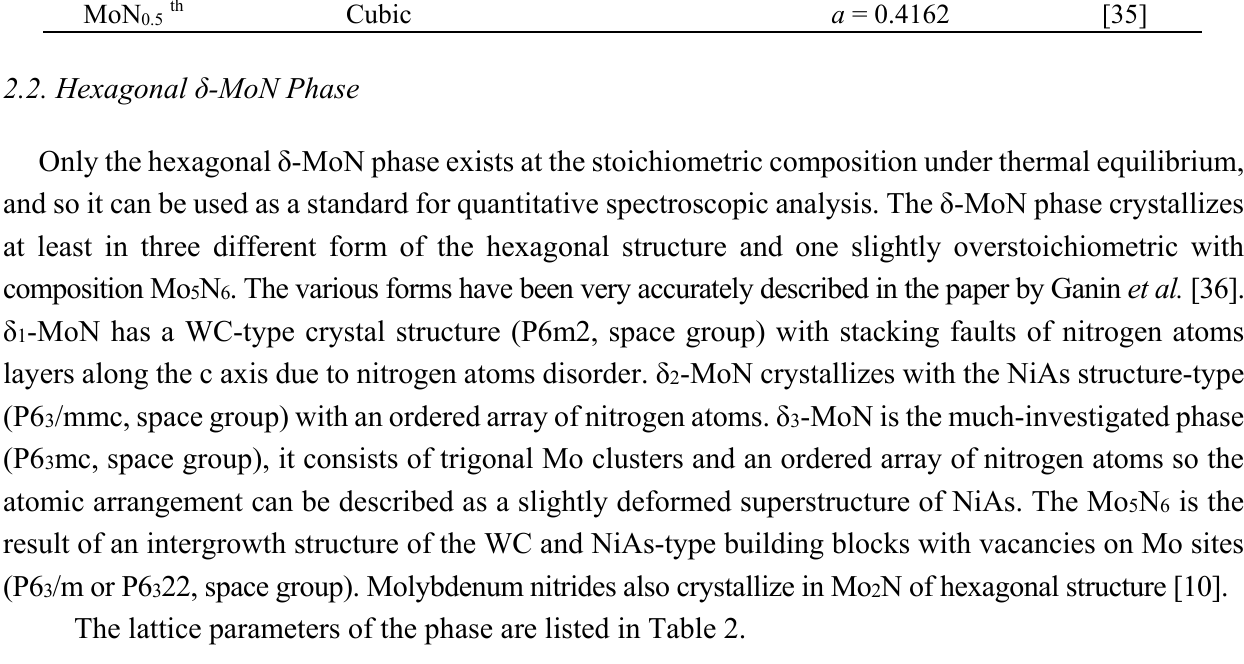
Table 2. Lattice parameters of MoN films ( f ) compared with bulk values ( b ), and theoretical values ( th ). Mo–N